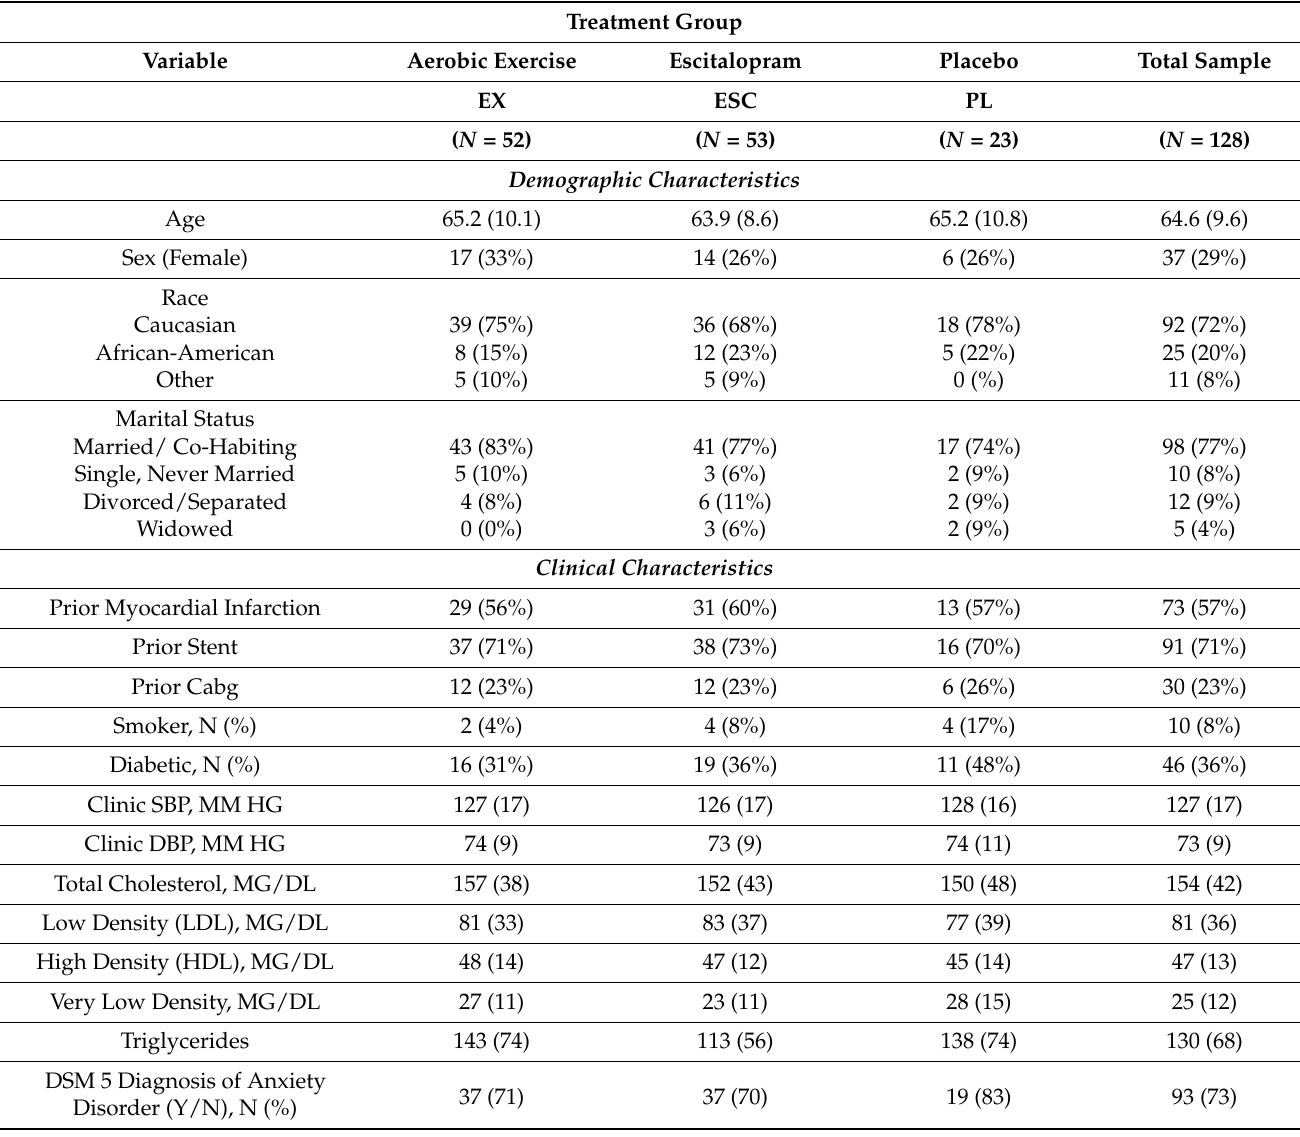
Table 1. Demographic and clinical